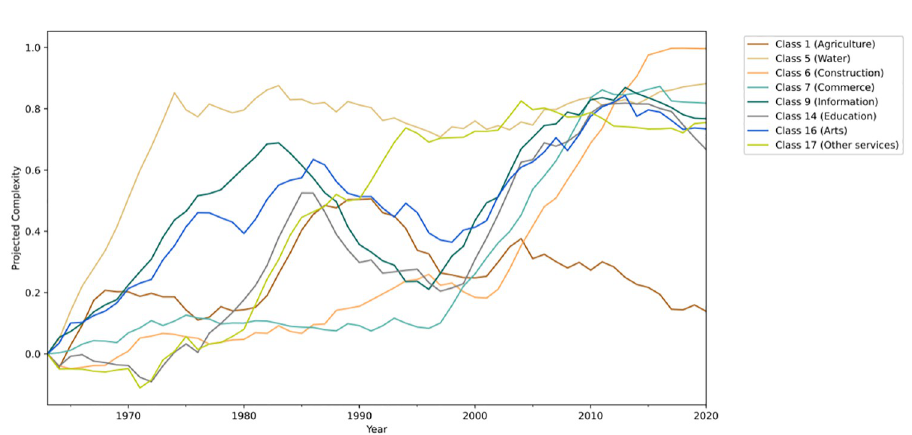
Fig 12. Complexity projection, a moving average of 14 years was used to smooth out the